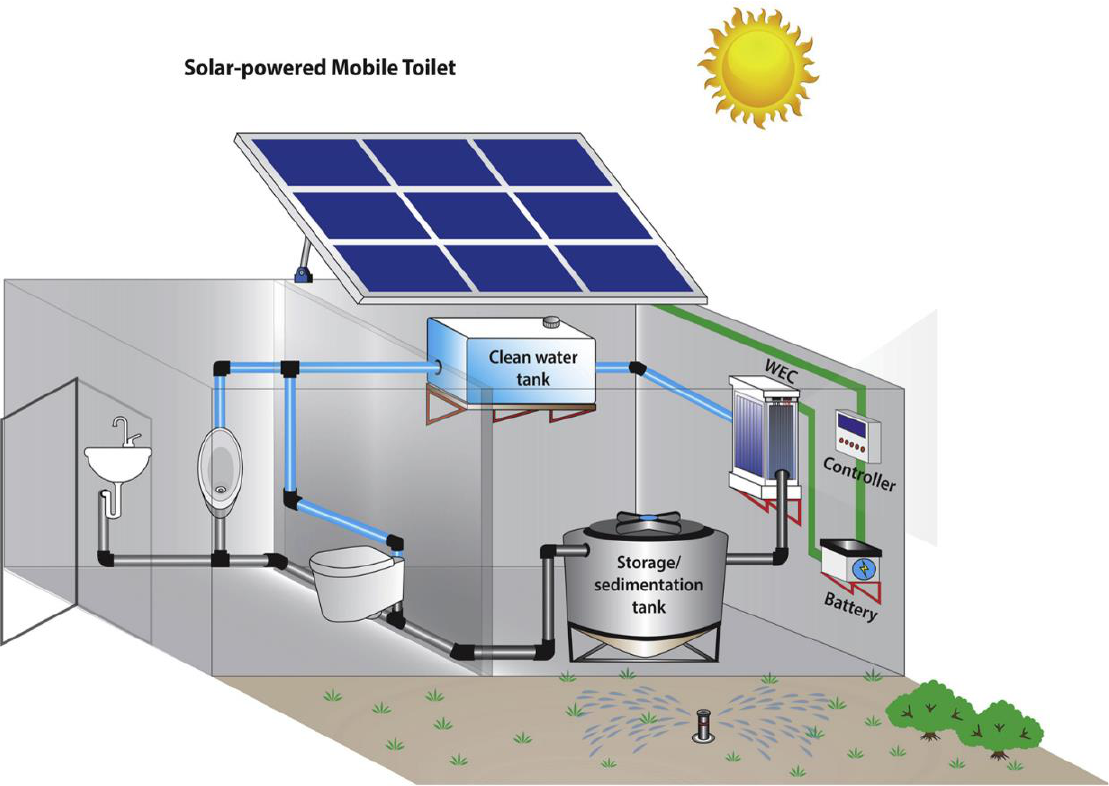
Figure 7. Schematic representation of the mobile toilet system employing the electrolysis cell powered by the solar panel for the treatment of BW, reported by Xiao Huang et al. Reused under the Creative Commons license [34] .